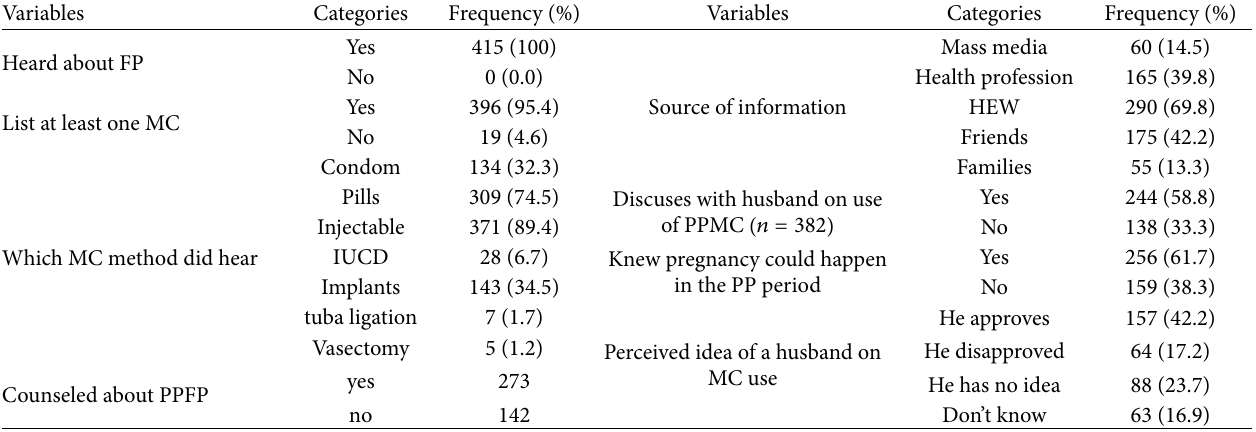
Table 3: Contraceptive knowledge of mothers, in Sekota town and its Surroundings, Northwest, Ethiopia 2017 (𝑛 = 415) . Variables